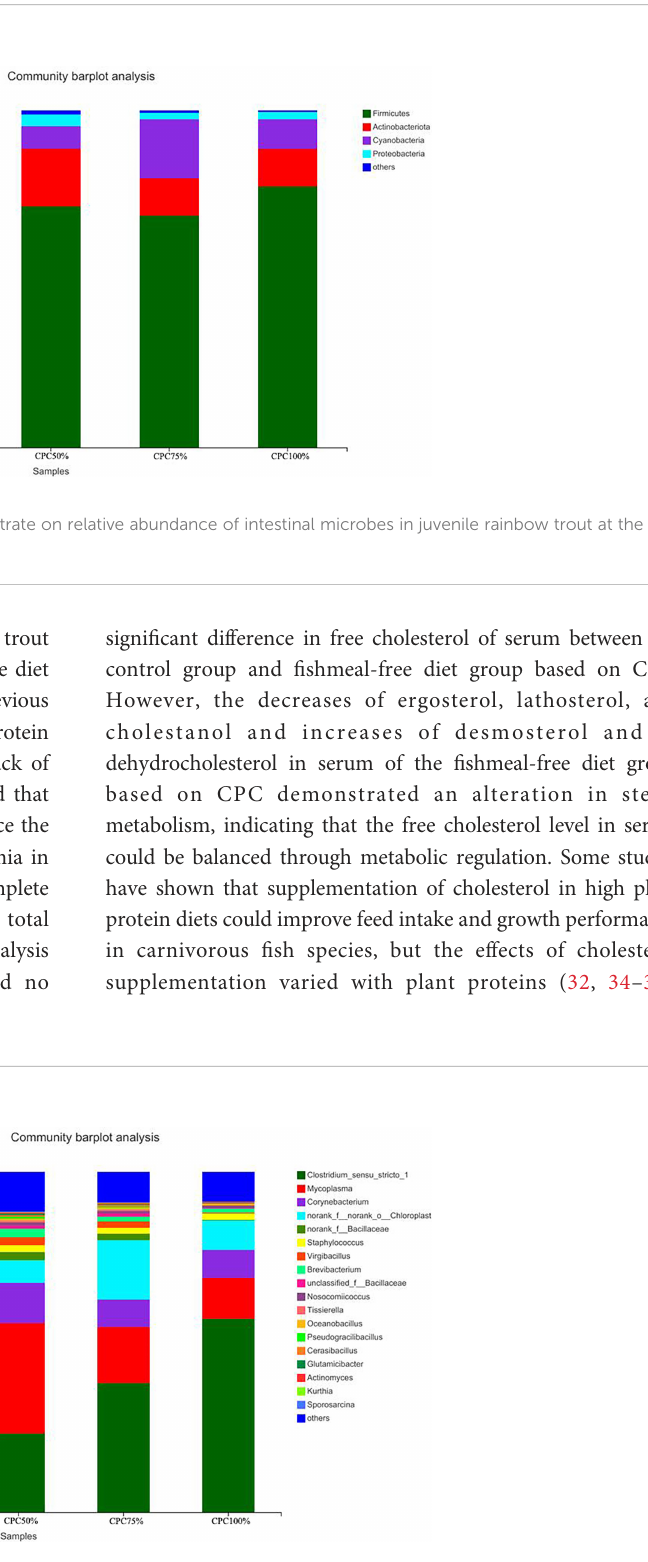
FIGURE 8 Effects of fi shmeal replacement by cottonseed protein concentrate on relative abundance of intestinal microbes in juvenile rainbow trout at the genus level.